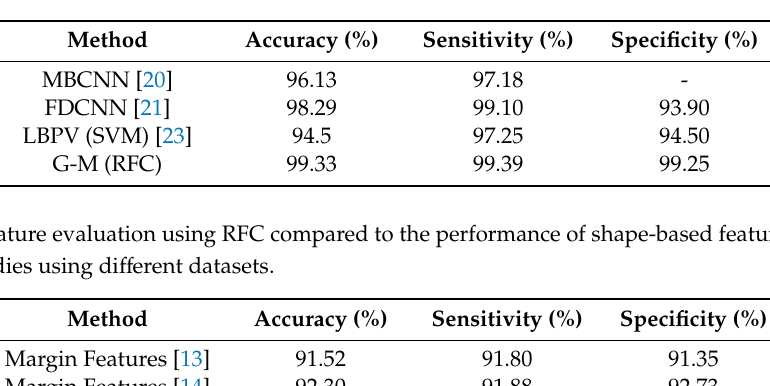
Table 5. Feature evaluation using RFC compared to the performance of the related approaches using the same dataset.